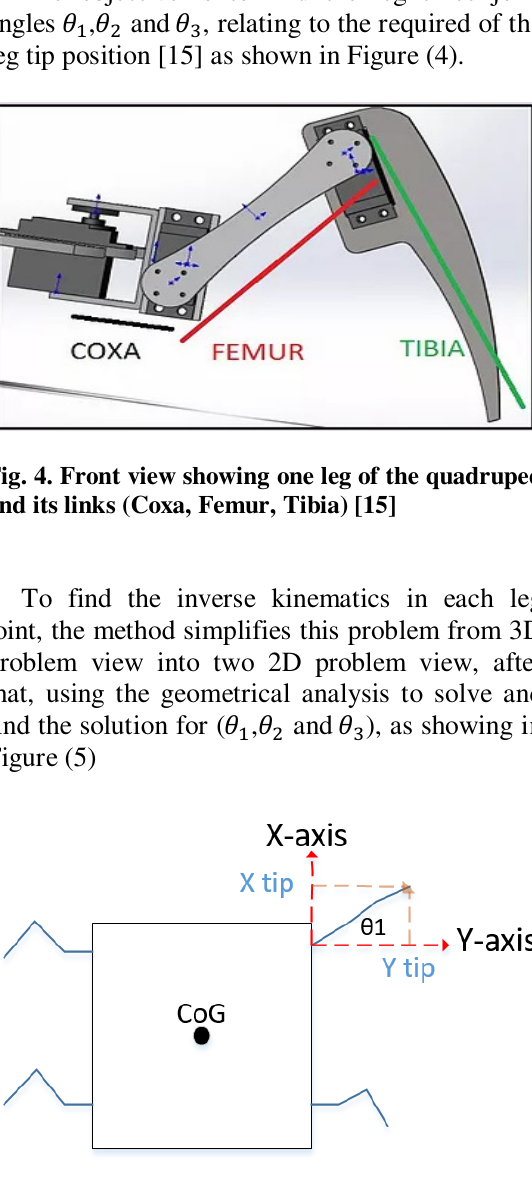
Fig. 5. Quadruped top view showing From Figure